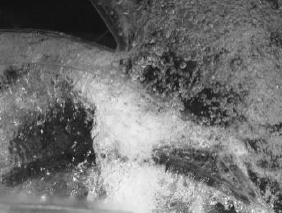
Figure 8. Flow behavior at different flowrate for α = 2% for a fixed rotor-stator position.